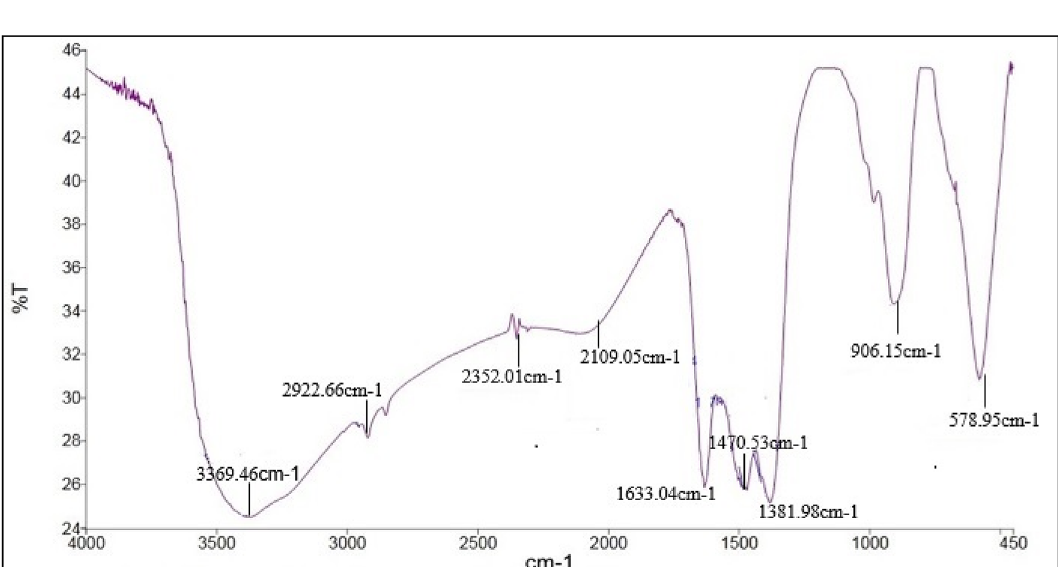
Figure 9. Fourier transforms infrared spectroscopy (FTIR) of Alk-ZnO